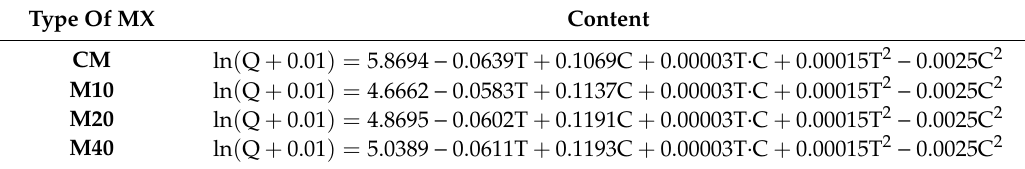
Figure 1. Response surface plots analysis (RSP) for the content of resveratrol as a function of the type of MX: ( A ) CM, ( B ) M10, ( C ) M20 and ( D ) M40. The symbols (*) in each RSP represent the center and start points for estimation of second order effects. Table 4. Predicting equations extrapolated from SRP for the content of resveratrol in BJ-MX, as a function of type of MX.